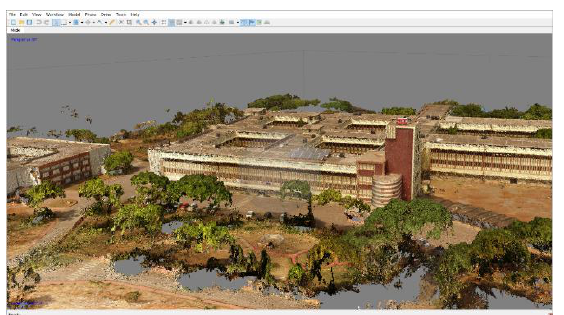
Fig.6. Point cloud of NIT Raipur